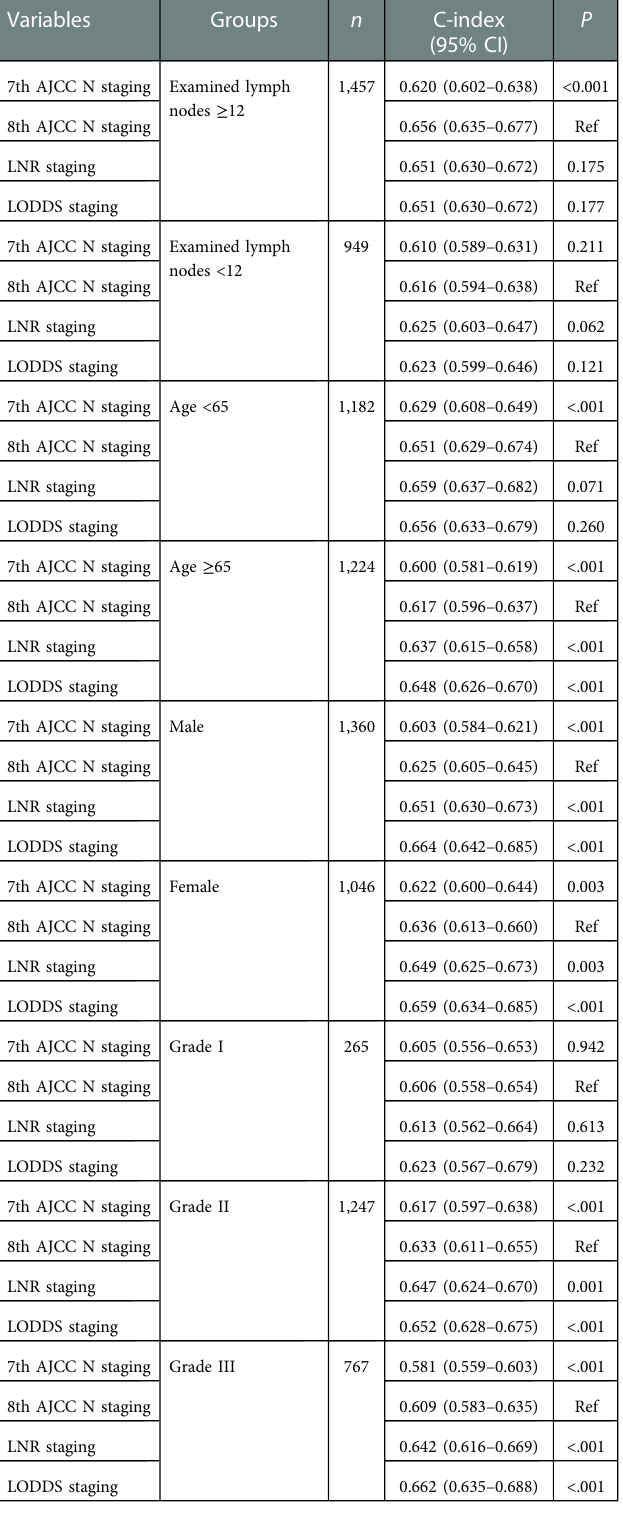
TABLE 4 The association between four staging systems and OS of all participants in the subgroups of examined lymph nodes, age, gender and ACs